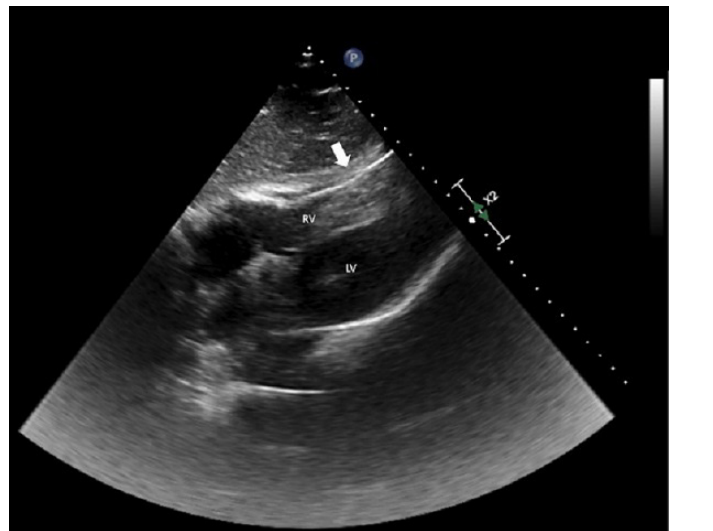
Image 2. Point-of-care echocardiogram subcostal view during systole showing ventricular pacer lead (arrow) beyond right ventricular chamber. No pericardial effusion is seen. RV, right ventricle; LV, left ventricle.